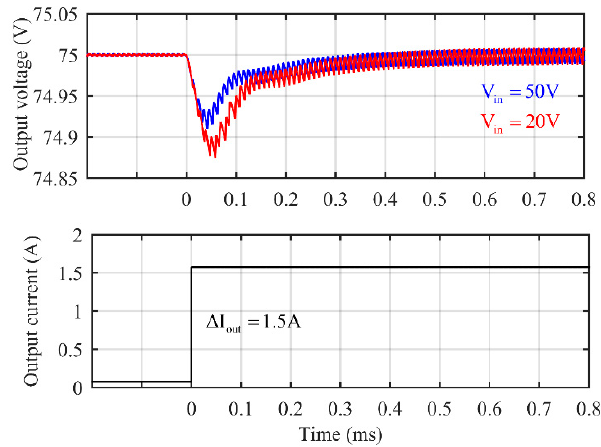
Figure 9. The output-voltage response to a load current change of 1.5 A at the input voltages of 20 V (red) and 50 V (blue).